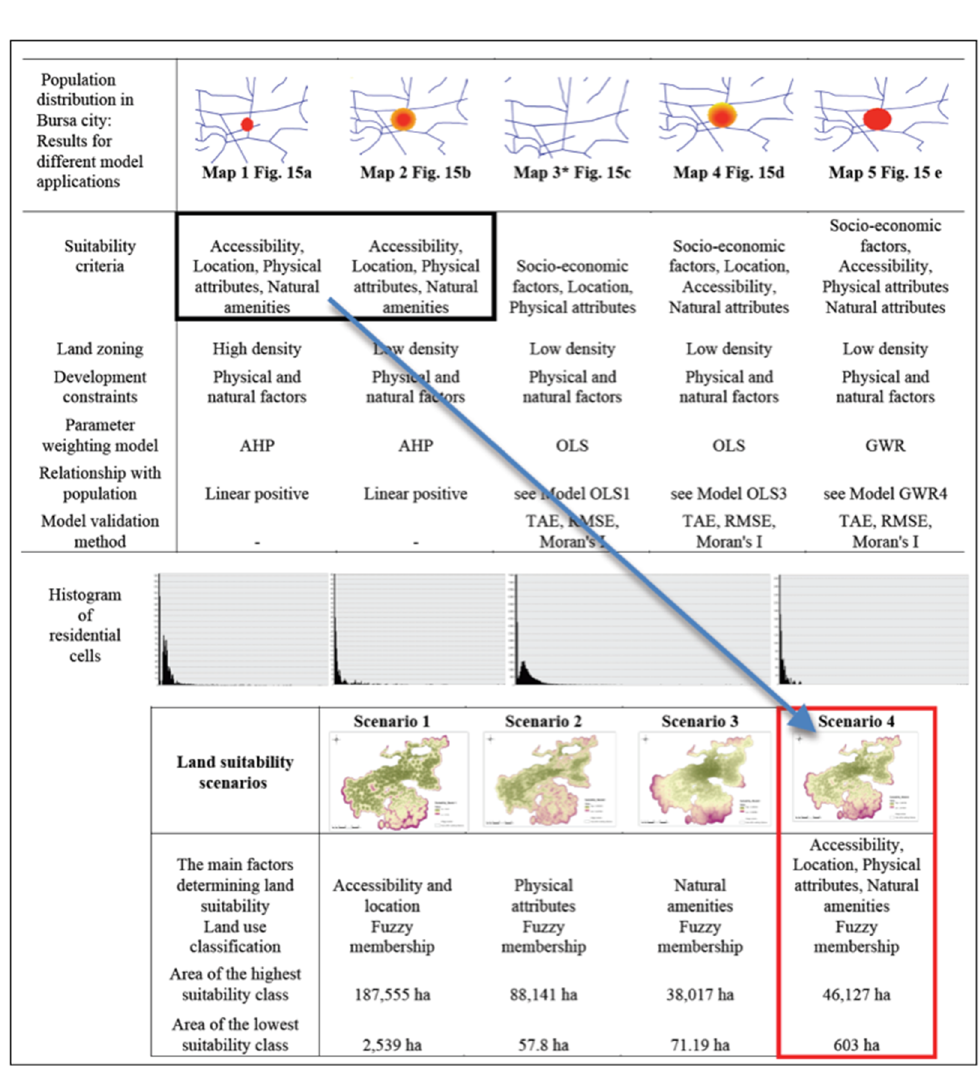
Figure 12. An overview of population mapping models. *Because Model OLS1 in Map 3 is based on villages with population smaller than 250, the model did not apply population distribution of Bursa city (population is more than 30,000).